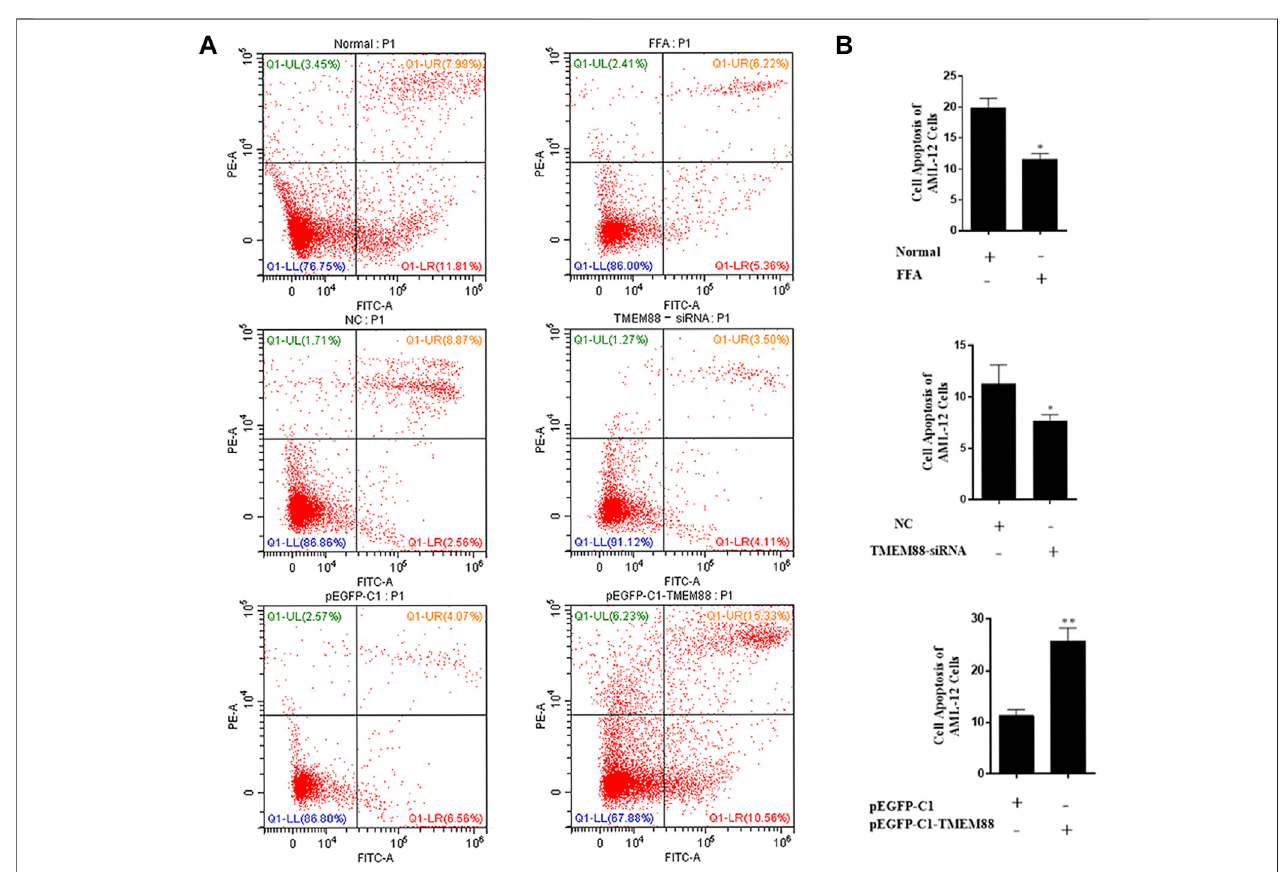
FIGURE 7 | Apoptosis of AML-12 cells induced was inhibited by FFA. (A,B) Flow cytometer results indicated that the expression of TMEM88 was positively correlated with AML-12 cell apoptosis. (The data are represented by at least three independent mean ± SD, * p < 0.05, ** p < 0.01 vs control group).